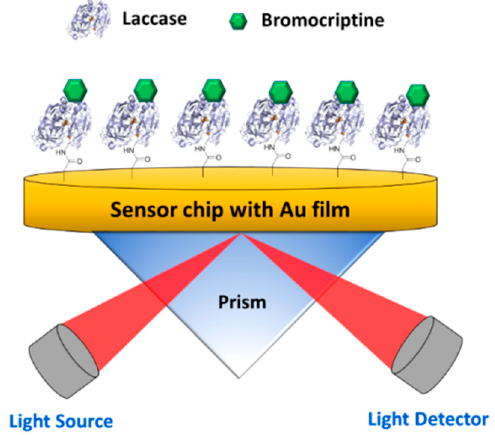
Figure 8. Schematic diagram of a novel enzyme based surface plasmon resonance (SPR)-biosensor for the detection of bromocriptine (BC). Laccase was used to design a SPR-based affinity biosensor for BC detection. Adapted from [115].